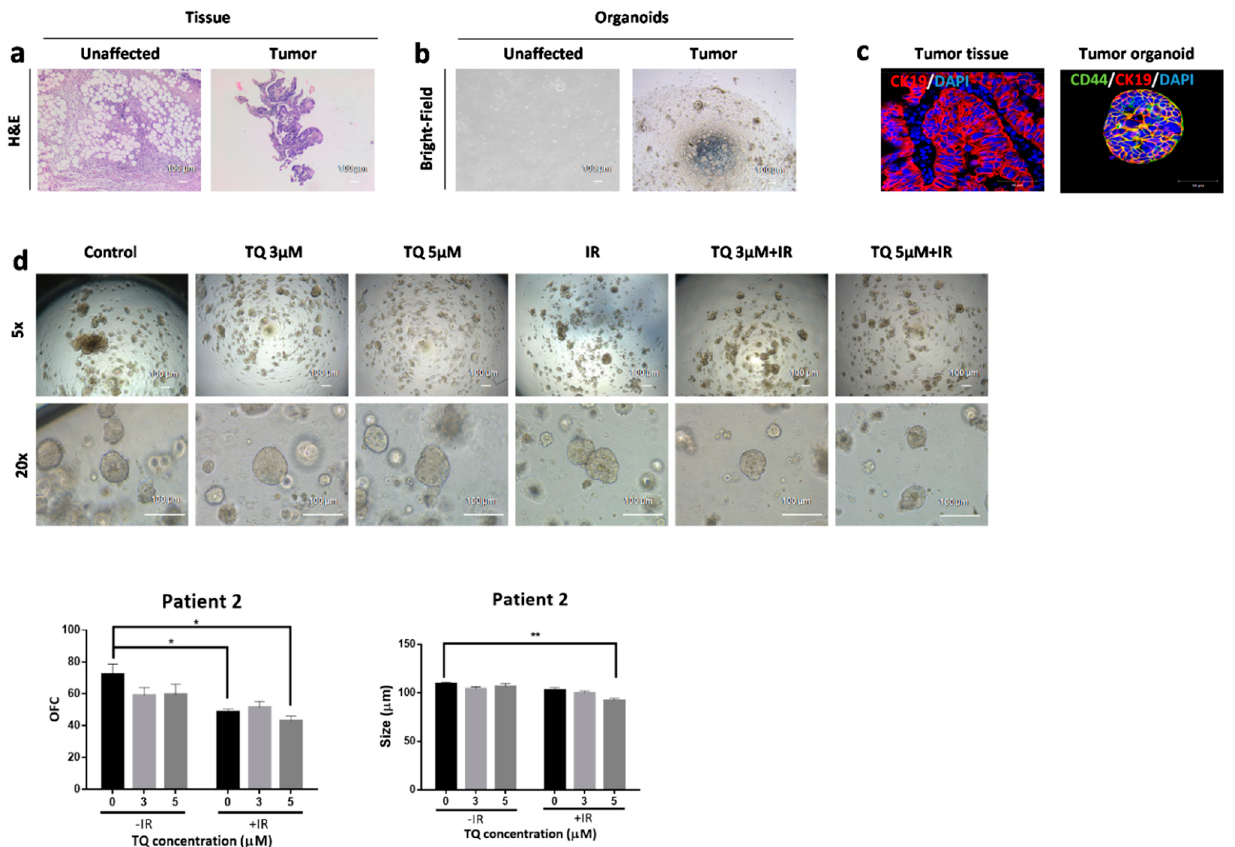
Figure 7. TQ and radiation reduce organoid-forming ability and size of patient 2-derived colon cancer organoids. ( a ) Representative images of H&E stain of unaffected and tumor colon tissue from patient 2. ( b ) Representative bright-field images of organoids derived from unaffected and tumor colon patient samples (patient 2). ( c ) Immunofluorescent images of tumor colon issues and organoids stained for CD44 and CK19. Images were obtained using confocal microscopy. ( d ) Representative bright-field images of organoids derived from tumor colon patient 2 sample and treated with TQ (3 and 5 µM), radiation (2 Gy), or combinations. Fresh unaffected and tumor tissues were digested, and single cells were resuspended in 90% Growth Factor reduced Matrigel and 10% serum-free colon media and allowed to grow in serum-free colon media (without treatment). Generated organoids are referred to as G1 organoids. Organoids were propagated to G4 and treated with TQ, IR, or combination. OFC and size were calculated, and average values were reported as mean ± SEM (* p < 0.05, ** p < 0.01. Images were visualized by Axiovert inverted microscope at 10× magnification. Scale bar for bright-field images is 100 µm and for immunofluorescent images is 50 µm.